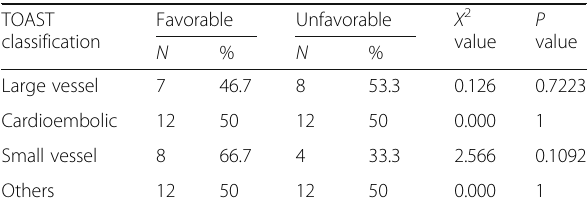
Table 3 Outcome of different subtypes of TOAST classification in group